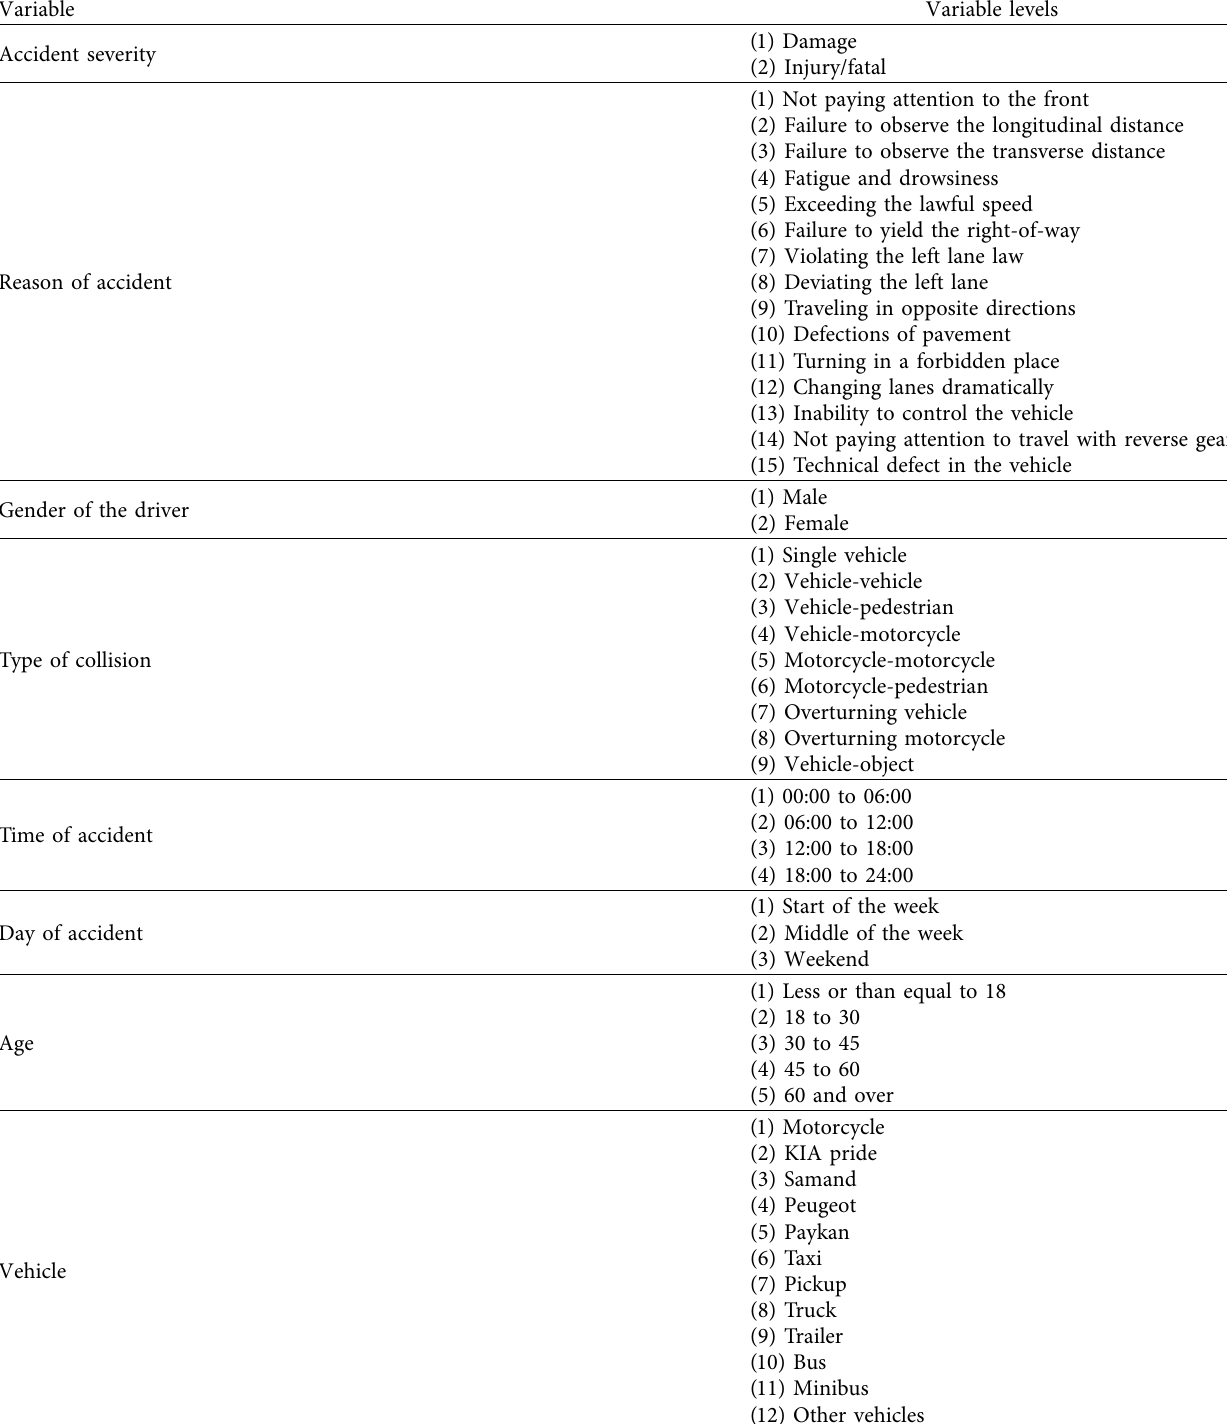
Table 1: Description and coding of each variable used in the